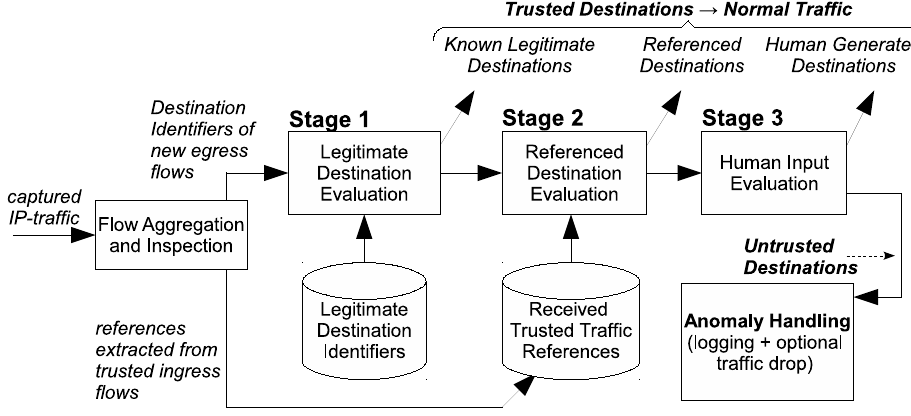
Figure 1. Schematic overview of UDI